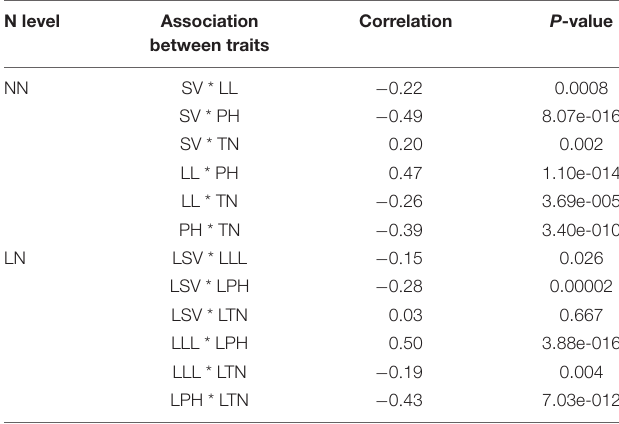
TABLE 1 | Correlation analysis of the mean amount on low-nitrogen-induced growth response (LNGR) agronomic traits. N